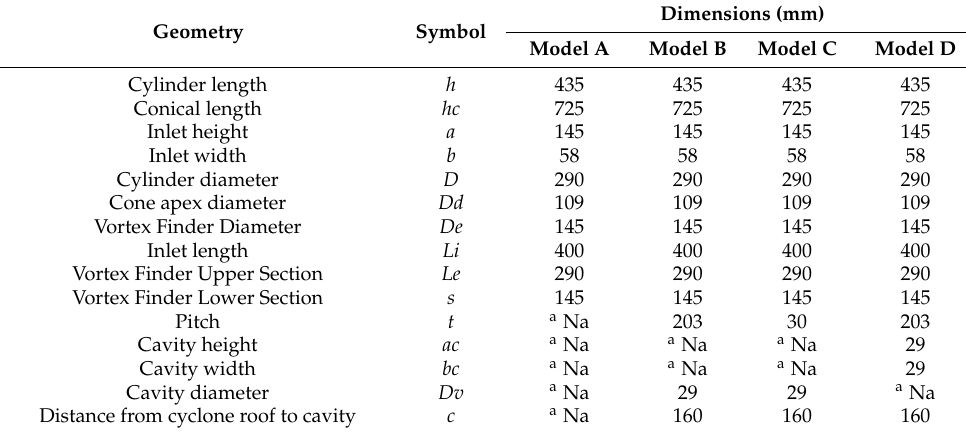
Table 1. Geometrical details of the Stairmand high-efficiency particulate separator cyclone and the new particulate separator cyclone models based on passive flow control